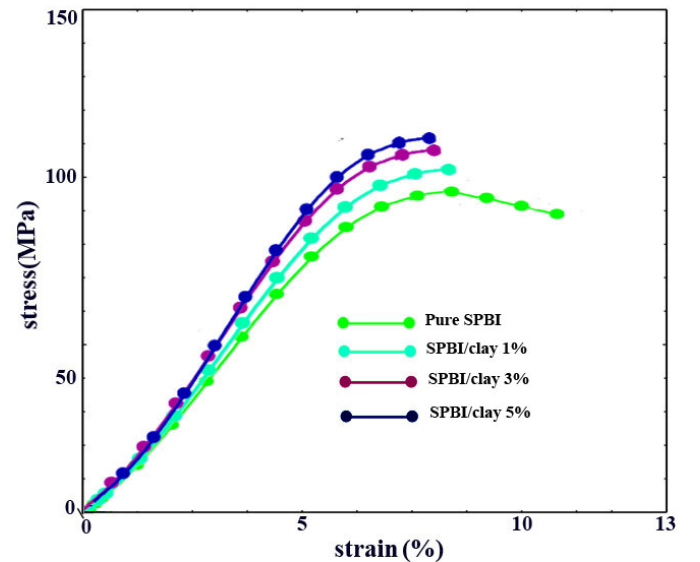
Fig. 8. Stress-strain curves of Pure SPBI and SPBI/clays with different organoclay content Fig. 8